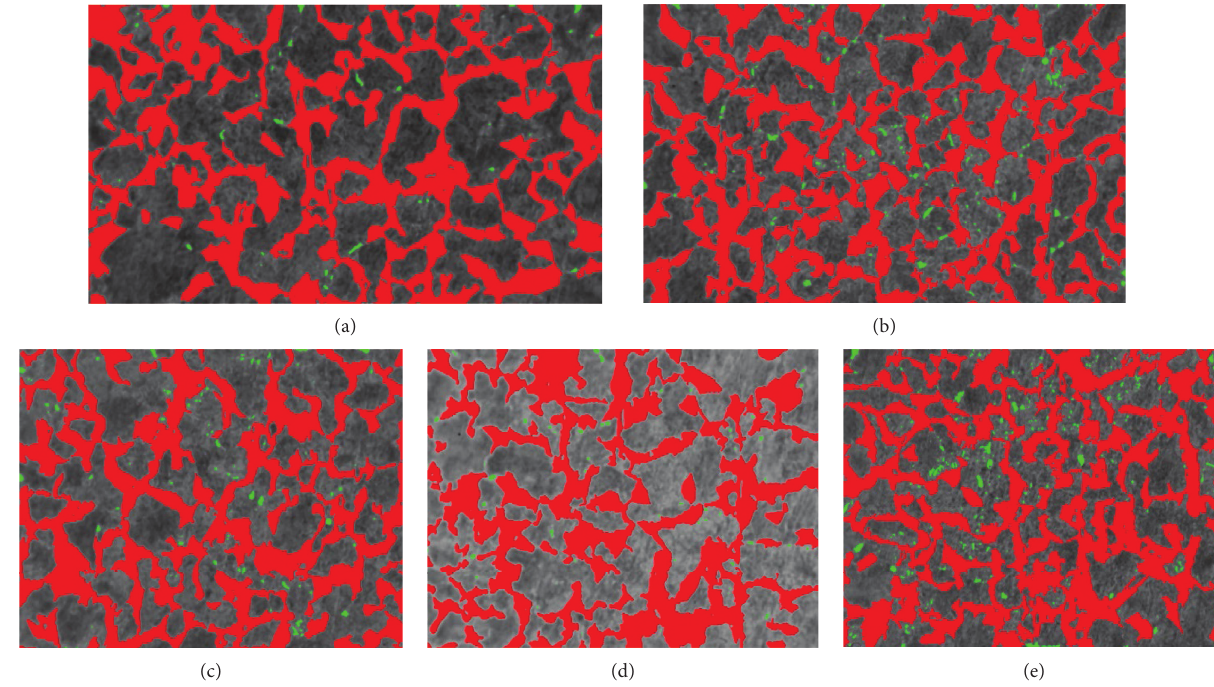
Figure 19: Quantitative analysis of structural elements when exposed into a covering agent in the field of view. № 1—excess ferrite concentration of 32.6751% (a); № 2—excess ferrite concentration of 33.5124% (b); № 3—excess ferrite concentration of 35.7860% (c); № 4—excess ferrite concentration of 33.7661% (d); № 5—the concentration of excess ferrite 37.7756% (e) ( ×